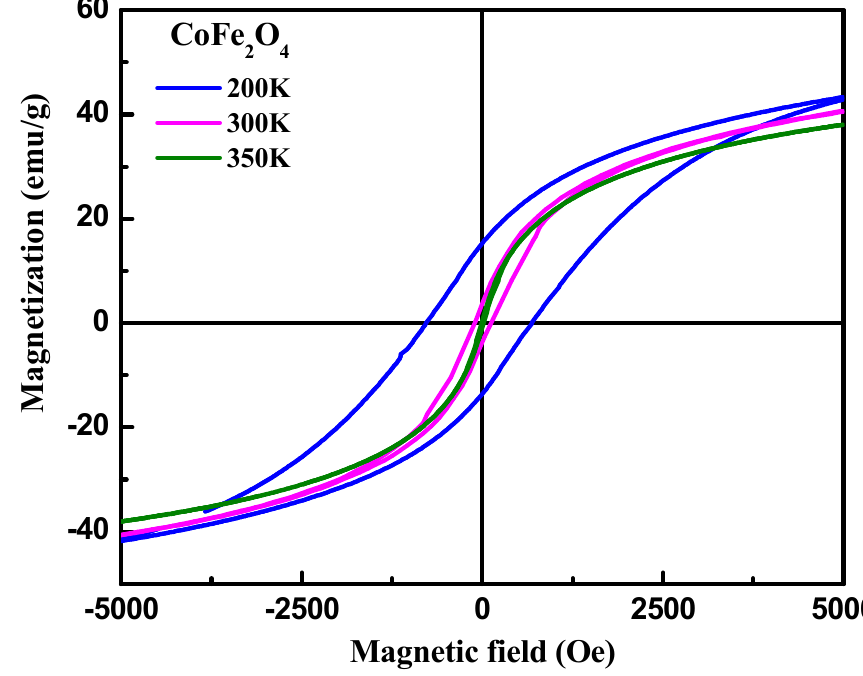
Figure 4. Hysteresis loops of CeFe 2 O 4 nanostructures at different temperatures. Table 1. Saturation magnetization (Ms), and remanence magnetization (M R ), coercive field (H C ) of CeFe 2 O 4 nanostructures calculated from M-H curve at different temperatures. 200 K